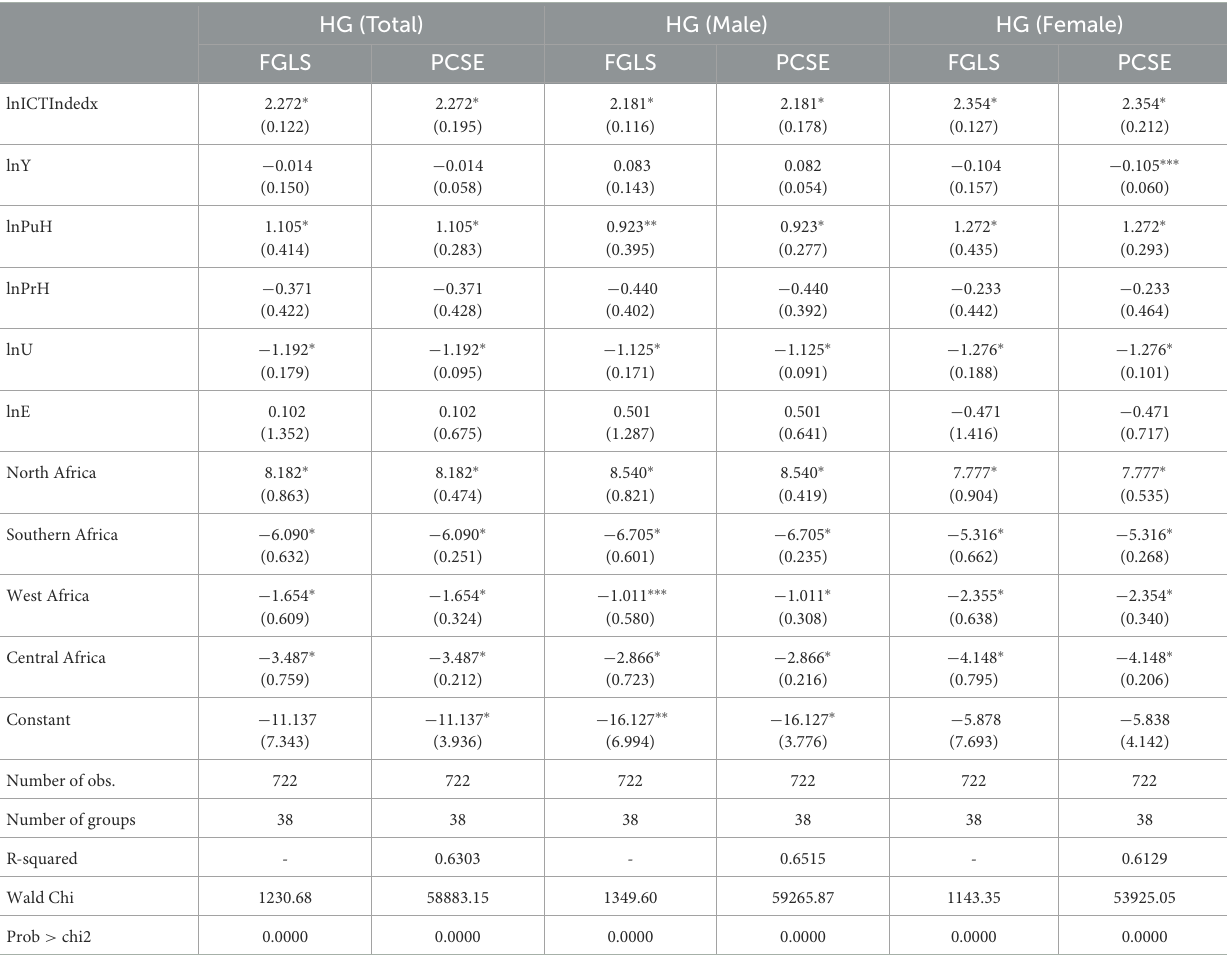
TABLE 7 FGLS and PCSE (dependent variable: health